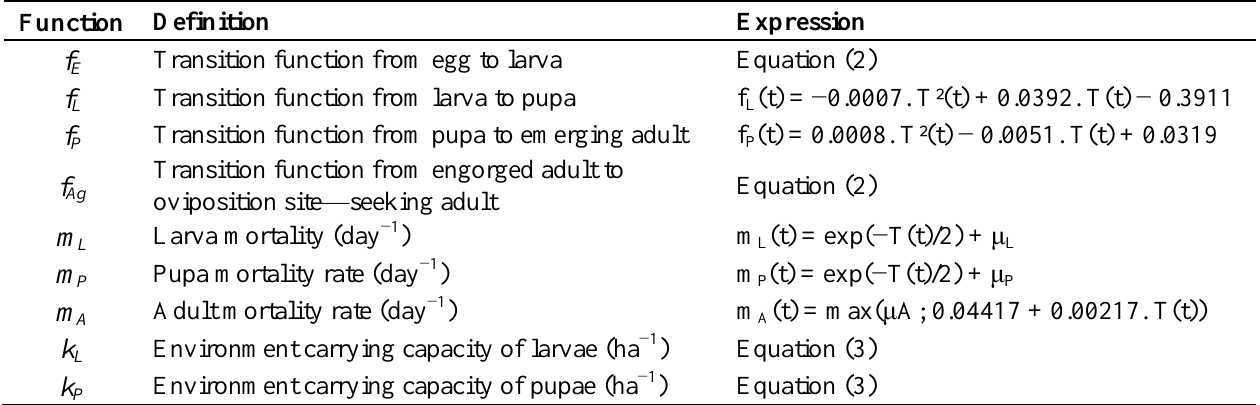
Table 3. Functions of the model of mosquito population dynamics adapted to Aedes albopictus in Mediterranean temperate